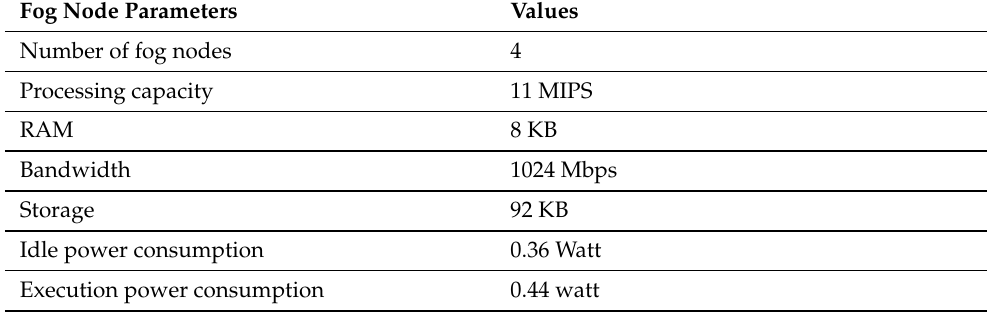
Table 3. Fog node parameters.